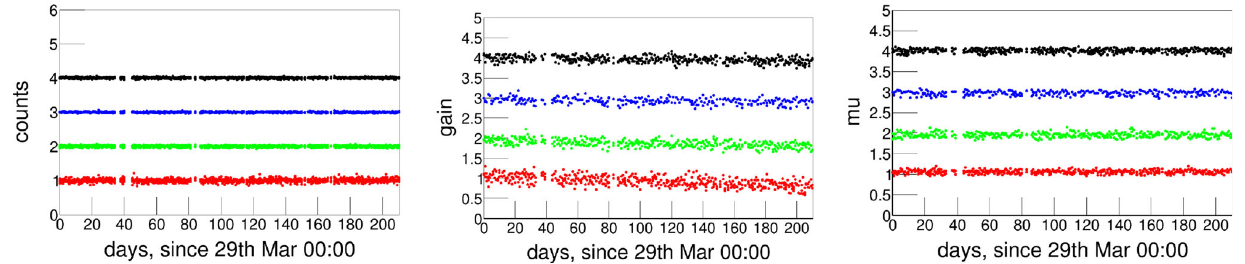
Fig. 44 Monitored DCR (left), gain (middle) and light intensity (mea- sured number of p.e.s in µ, proportional to PDE, configured with con- stant light intensity, right) versus operating time under different config- urations. There was an artificial shift introduced between each testing group on the plots to improve differentiation of the trend of each con-